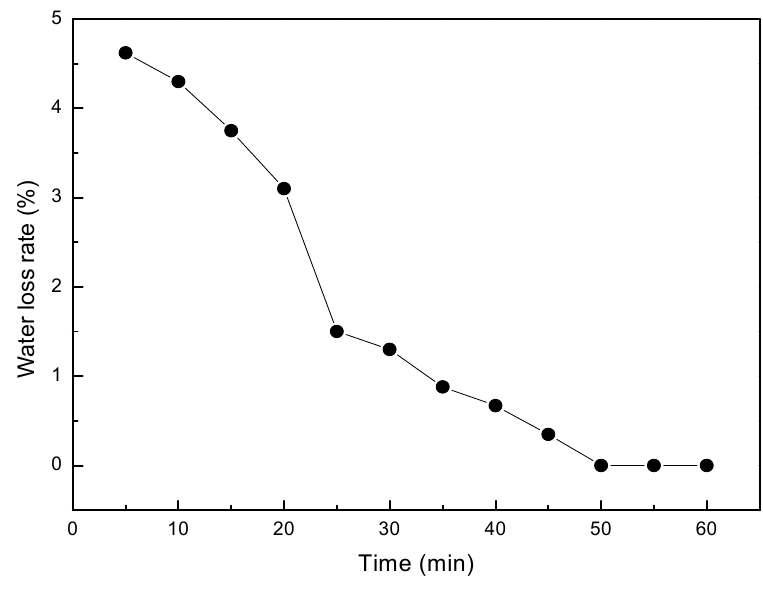
Figure 3. Water loss rate of Cu-IPMC (L4).